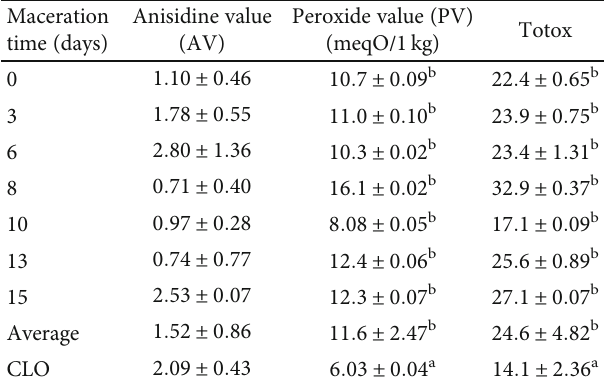
a,b Kruskal-Wallis test: values marked by letter symbols a, b, … , are statistically signi fi cant, p < 0 : 05 (values read in separate columns, marked with the same letter, do not di ff er signi fi cantly; those marked with di ff erent letters di ff er signi fi cantly).